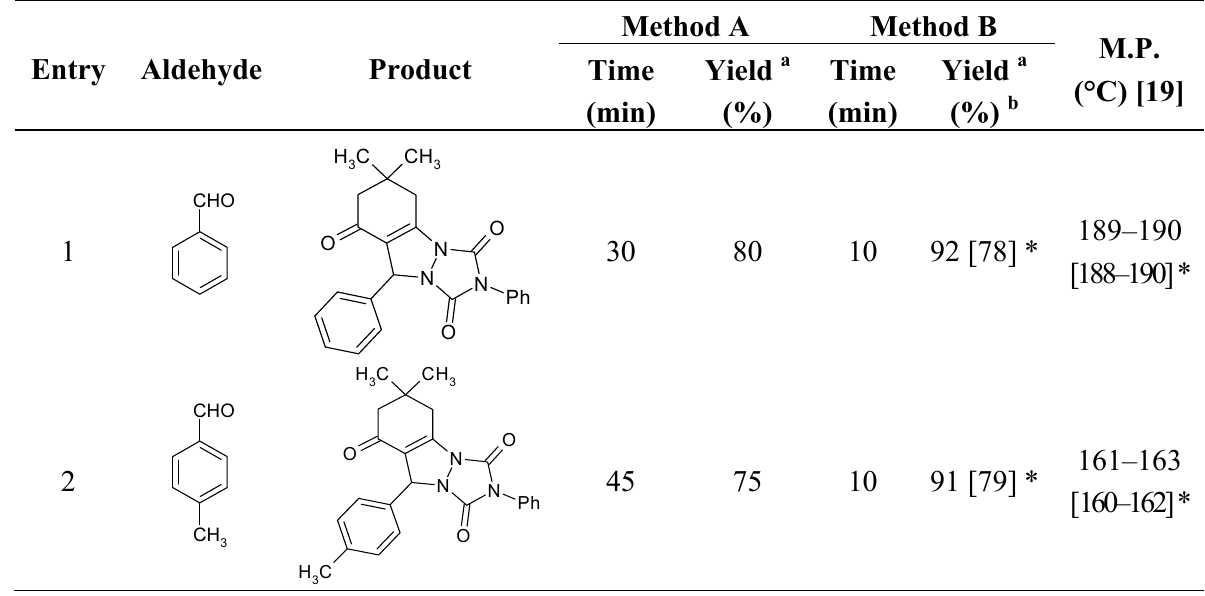
Table 3. Synthesis of triazolo[1,2-a]indazole-1,3,8-trione derivatives using nanosilica sulfuric acid obtained from rice